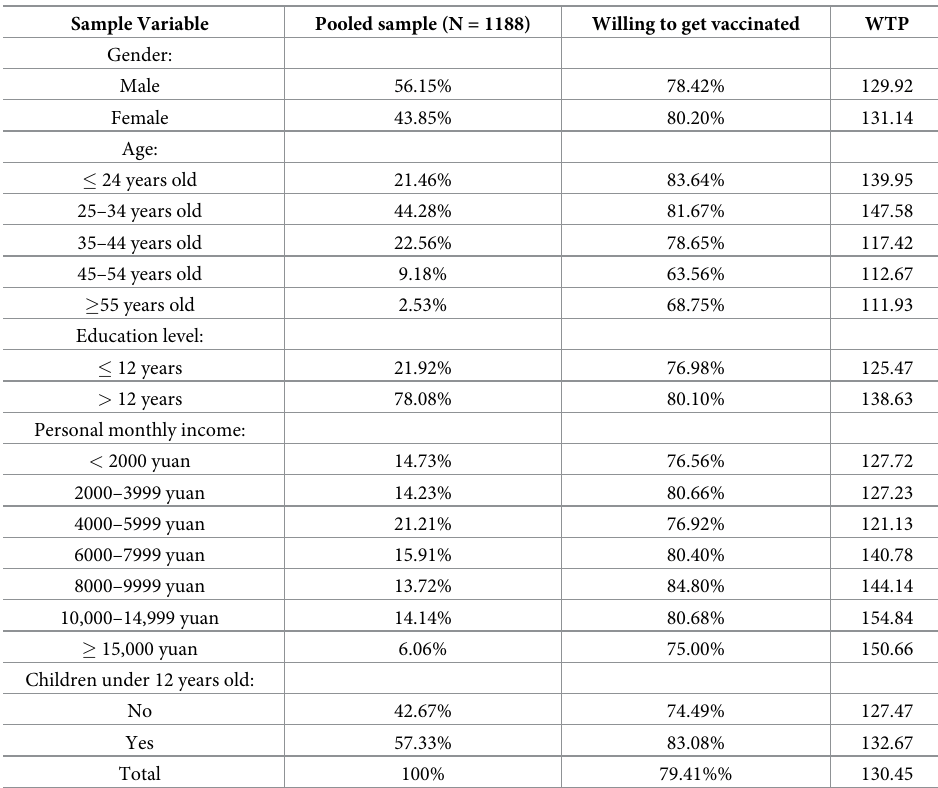
Table 2. Descriptive